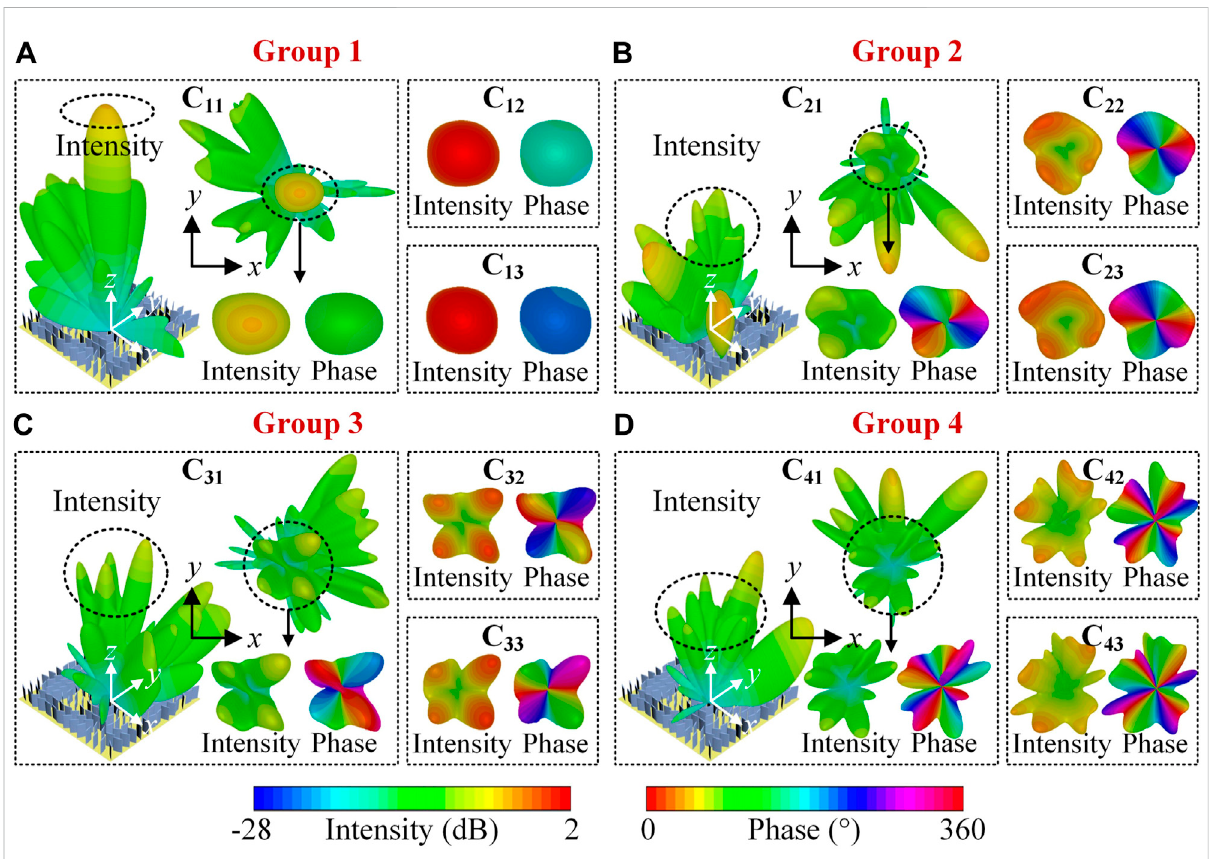
FIGURE 6 Simulated far fi eld patterns of the RCP re fl ected wave. RCP re fl ected waves are transformed into 3-channel orthogonal on-axis beams with different frequencies ( f 1 = 0.18 THz, f 2 = 0.23 THz, and f 3 = 0.28 THz) and the same topological charge (A) l 1 = 0 (B) l 2 = +2 (C) l 3 = -2 (D) l 4 = +4. Therefore, 12-channel orthogonal on-axis beams with topological or frequency orthogonality can be